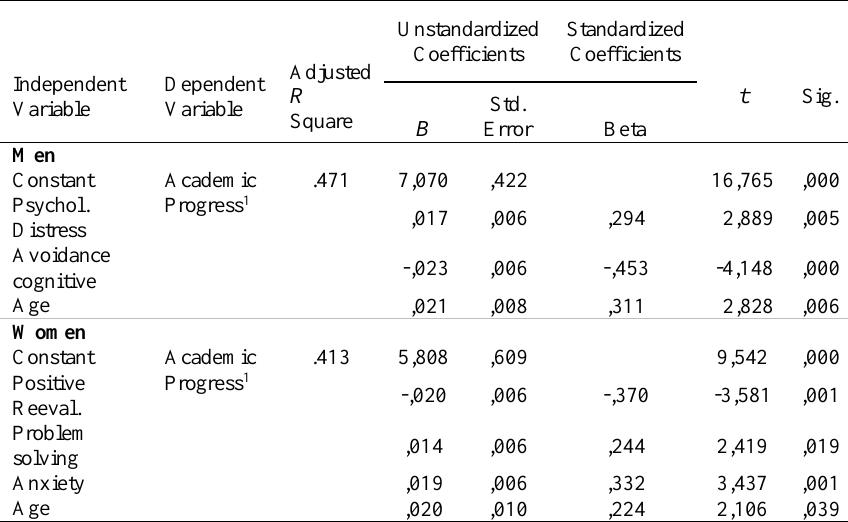
Regression model to study the link between psychological scales (BSI) and academic progress (GPA)